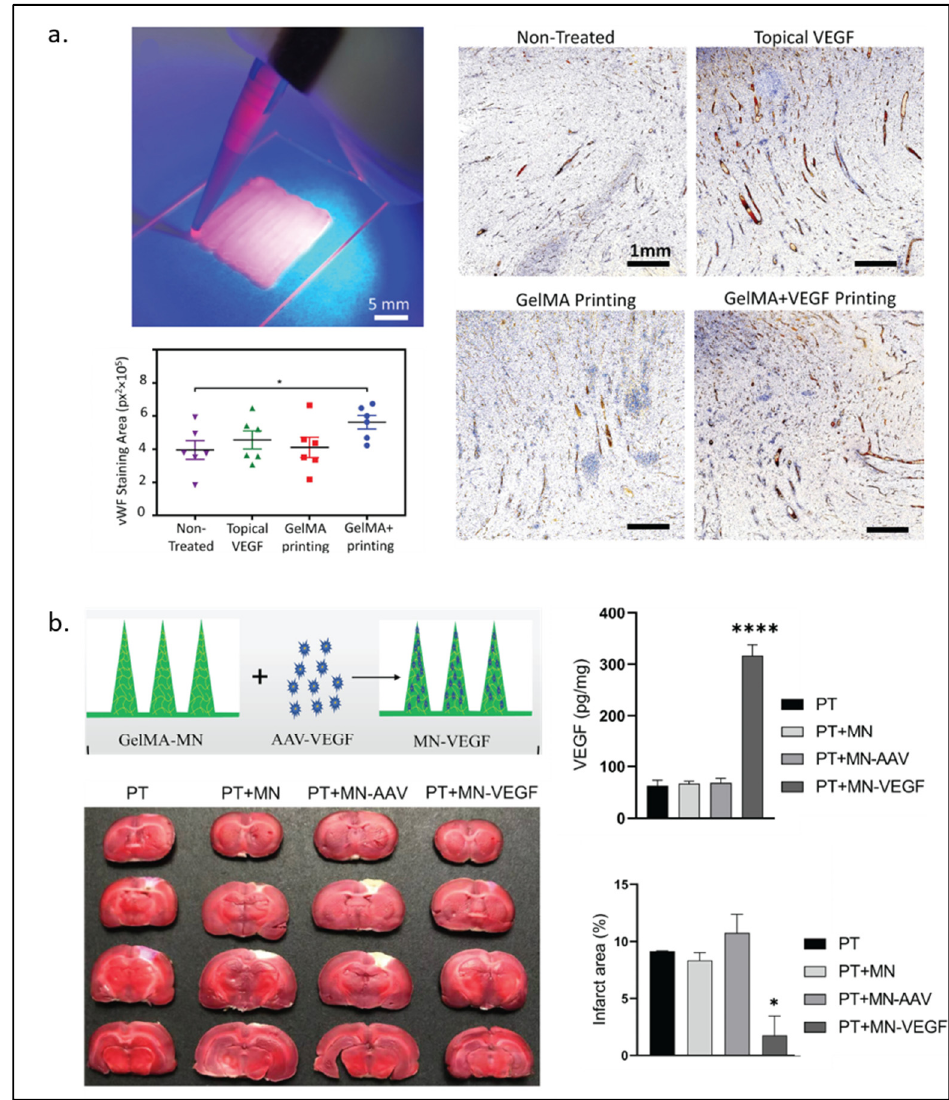
Figure 2. VEGF-modified GelMA hydrogel. ( a ) Handheld printing using VEGF-modified GelMA hydrogel as bioink for wound healing (left) and immunostained for von Willebrand Factor under an optical microscope (right) with quantitative results of wound bed angiogenesis by measure- ment of vWF signal in different wounds (n = 6). The data is presented as mean ± standard error of mean (SEM). Comparison of the different groups was performed using a student's T test and * represents p < 0.0005 (bottom left). ( b ) Schematic illustration of GelMA-microneedles loaded with AAV-VEGF and the results of cerebral ischemia treatment in rats among different groups treated. (Photothrombotic (PT), microneedle (MN), adeno-associated virus (AAV), vascular endothelial growth factor loaded microneedle (MN-VEGF)). Statistical analysis was performed using a two- sided Student's t-test or one-way analysis of variance (ANOVA). of the infarct area (upper right) and the protein levels of VEGF in the brain 3 weeks after MN implantation (lower right). The data are expressed as the mean ± SD. * p < 0.05 and **** p < 0.0001. Reproduced (adapted) with permission from Ref. [23]. 2022 © Biomaterials, and from Ref. [27]. 2021 © Journal of Controlled